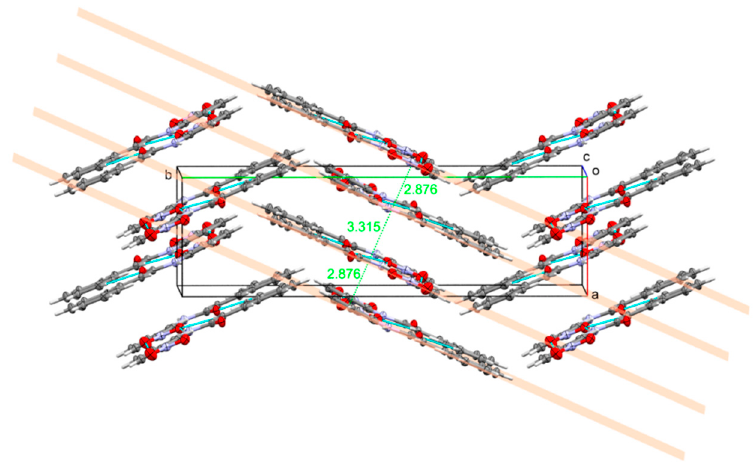
Figure 5. Herringbone arrangement of π -stacked ribbons viewed along the c-axis. Parallel planes defined by molecules shown in transparent beige. Interplanar distances are shown in green (Å).